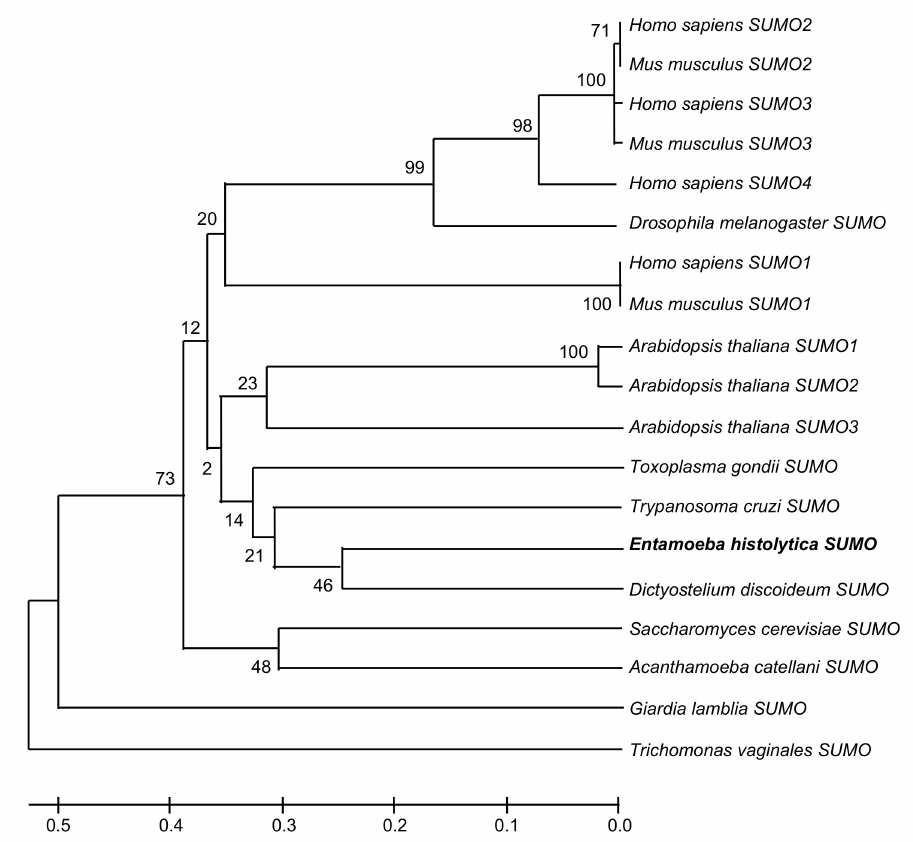
Figure 2. Phylogenetic analysis of EhSUMO. Phylogenetic tree performed by UPGMA, using MEGA 5.05 software, shows the position of E. histolytica SUMO protein among different species. Numbers in horizontal lines indicate the confidence percentages of the tree topology from bootstrap analysis of 1000